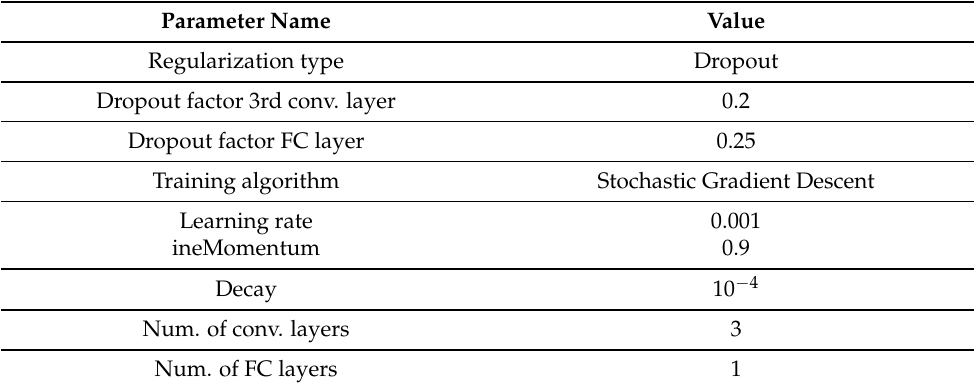
Figure 8. Structure of the Convolutional Neural Network in the locally tunable scenario. Table 4. Convolutional Neural Network architecture